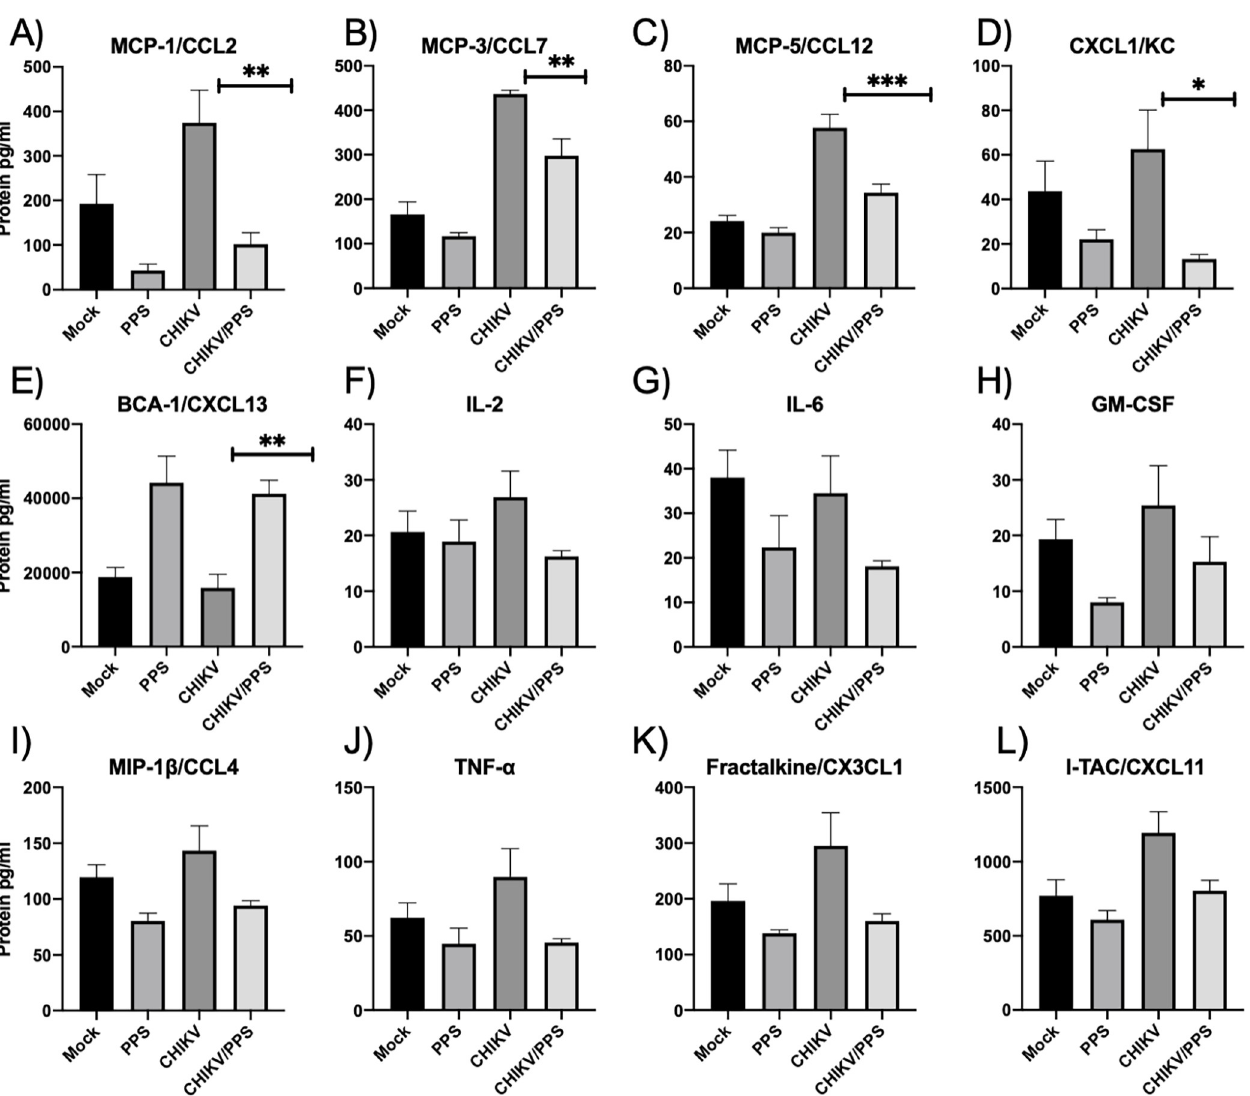
Fig 4. Effect of pentosan polysulfate sodium on the serum levels of chemokines and cytokines involved in inflammation. Chemokine and cytokine levels of mock, PPS alone (PPS), CHIKV-infected untreated (CHIKV) and CHIKV-infected PPS-treated (CHIKV/PPS) mice were assessed at peak disease (7 d.p.i.). All values are presented as mean pg/mL ± SEM of 5 mice per group. Expression was significantly reduced between CHIKV-infected untreated and CHIKV- infected PPS-treated groups. (A) CCL2 (101.8 ± 25.9 vs 374.6 ± 73, �� P = 0.058). (B) CCL7 (297.9 ± 37.6 vs 436.5 ± 8.9 �� P = 0.0047) (C) CCL12 (34.3 ± 3.1 vs 57.7 ± 4.9 ��� P = 0.0007) and (D) CXCL1 (13.2 ± 2.1 vs 62.6 ± 17.7 � P = 0.0331). (E) CXCL13 expression was significantly increased between CHIKV-infected untreated and CHIKV-infected PPS-treated groups (41239.5 ± 3612.3 vs 15868.6 ± 3636.2 �� P = 0.0080)). One-Way ANOVA with a Tukey’s post-test . (F-L) Chemokines/cytokines that displayed a decreased trend in protein expression without meeting statistical significance are also shown.